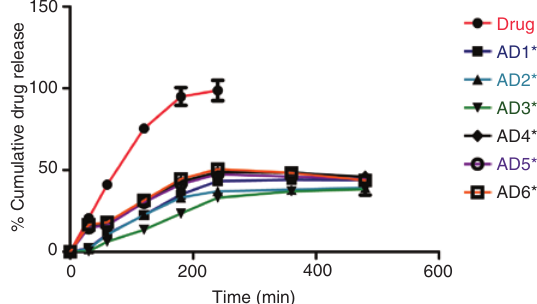
Figure 6: In vitro release profile of AZ from CS NP formulation. *Sta- tistically significant (p < 0.05) compared with the aqueous solution, as determined by one-way ANOVA followed by Dunnett’s test. Each bar represents the mean ± SD (n = 3).